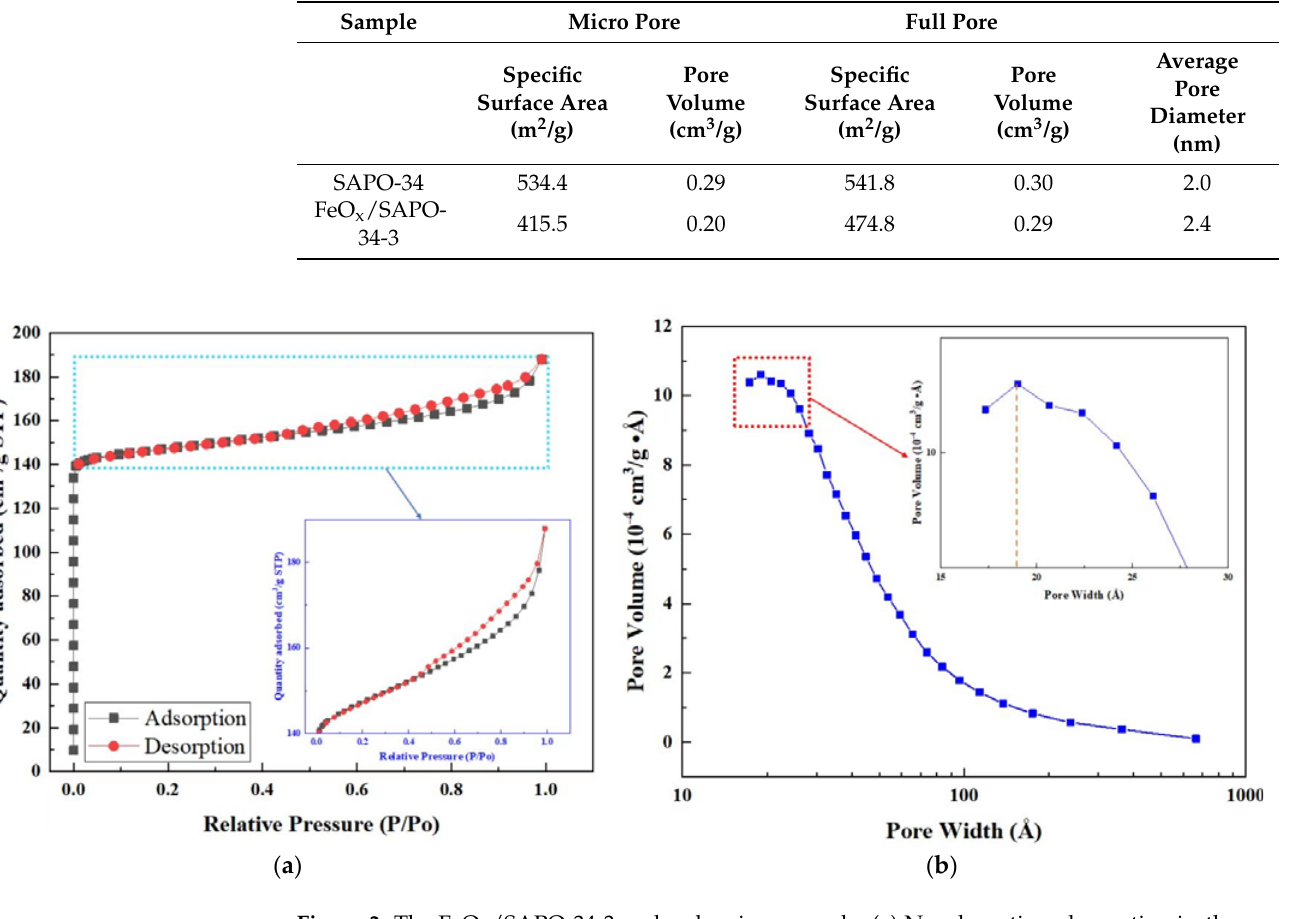
( b ) Figure 4. FeO x /SAPO ‐ 34 ‐ 3 molecular sieve sample prepared by an impregnation method: ( a ) Full XPS spectrum, ( b ) Fe 2p spectrum.